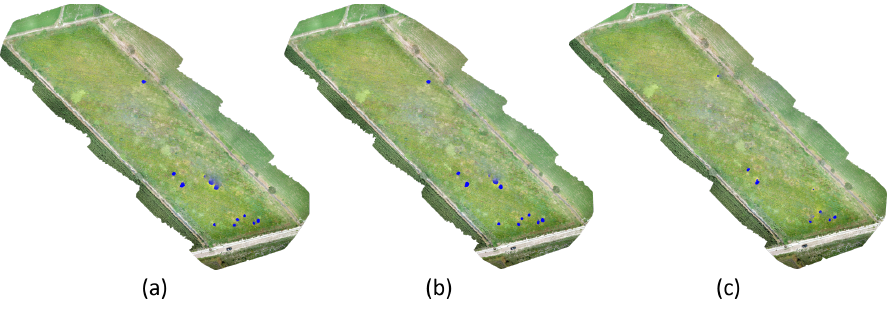
Figure 6. Generation of segmented orthomosaics with ( a ) manual segmentation, ( b ) the U-Net Xception-style model, and ( c )